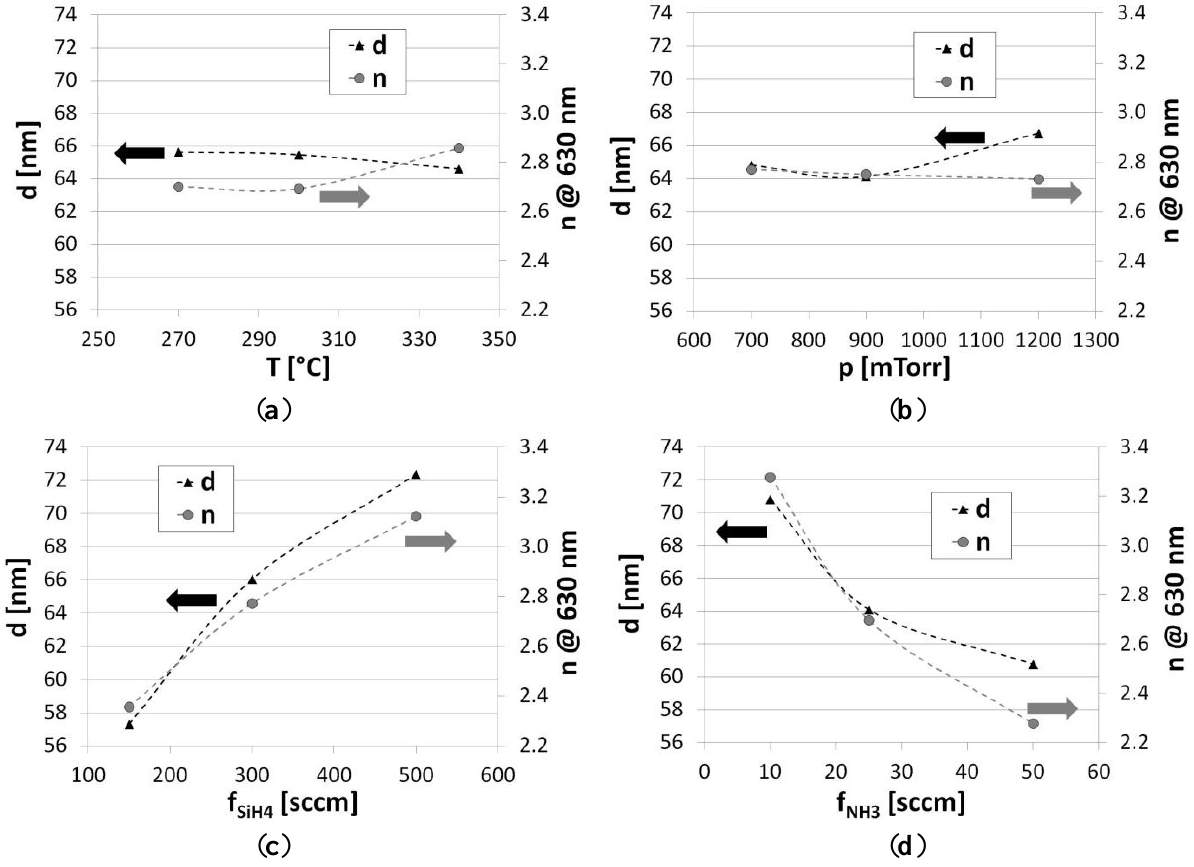
Figure 2. Influence of examined RF PECVD process parameters, i.e. , ( a ) temperature; ( b ) pressure; ( c ) SiH flows; and ( d ) NH flows, on d and n (determined at λ = 630 nm), 4 3 according to the data analysis with Taguchi’s orthogonal tables approach.